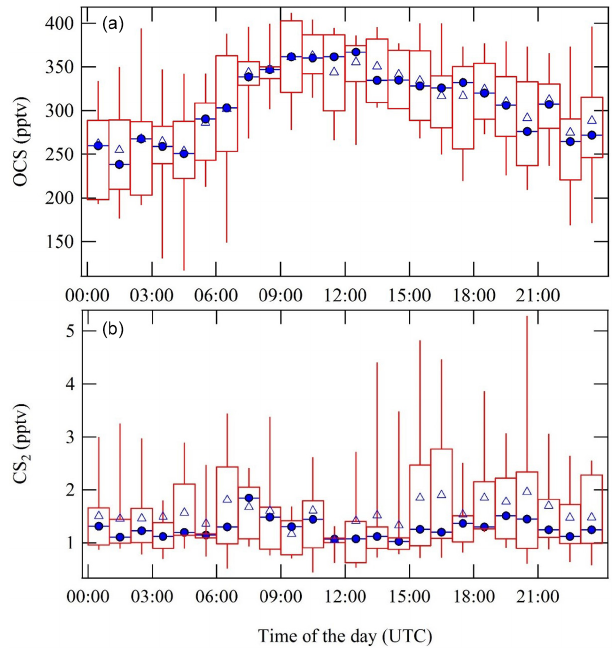
Figure 6. Diel cycles of OCS MRs (a) and CS 2 MRs (b) based on all AED-measured data points throughout the measurement cam- paign. Blue triangles show the overall hourly mean, and blue cir- cles show the hourly median values. The red rectangles with the whiskers show the data spread; 50% of the data points fall into the rectangles. The upper whiskers represent the upper 75th percentile data spread, and the lower whiskers denote the lower 25th percentile data